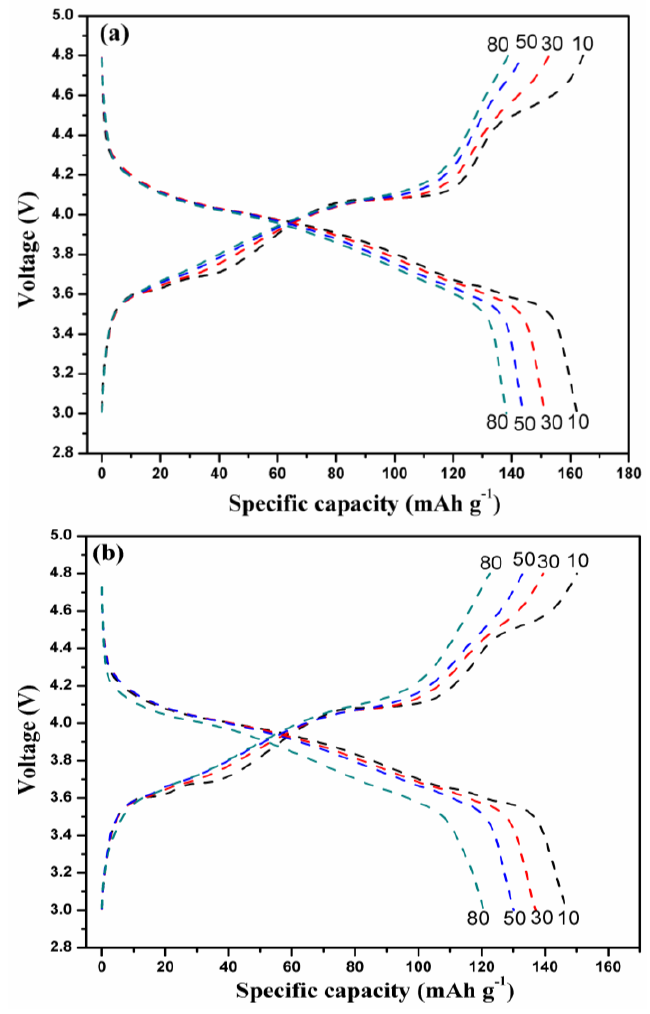
Figure 5. Selected charge/discharge curves of the LVPBC ( a ) and pristine LVPC ( b ) composites at the current density of 30 mA · g −1 in the voltage range of 3.0–4.8 V.